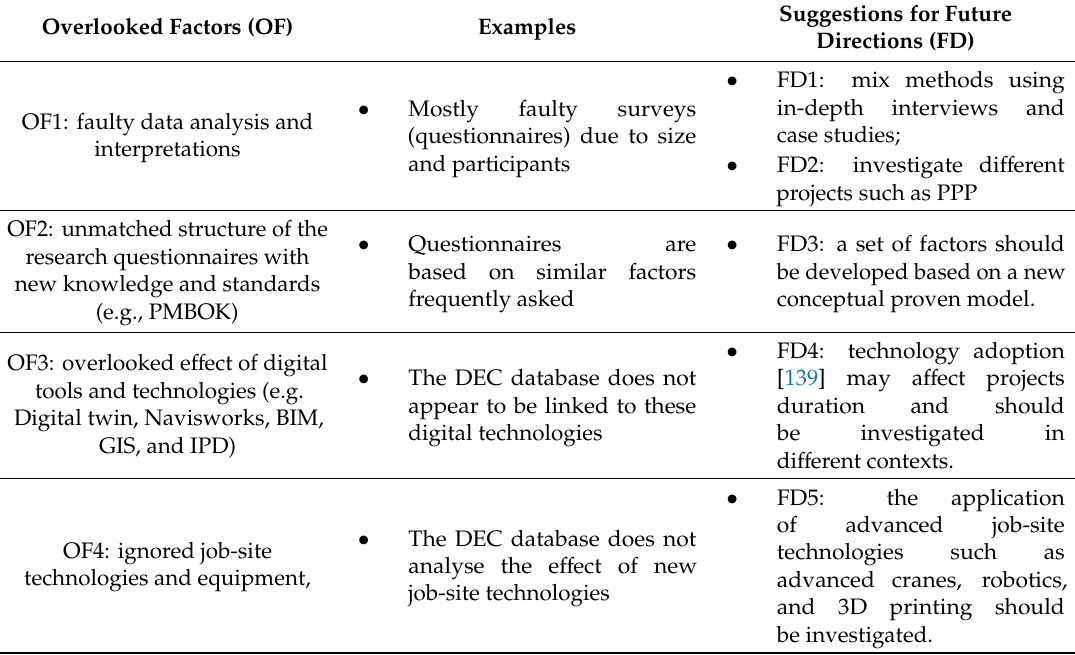
Table 11. Future directions based on deficiencies of the current delay